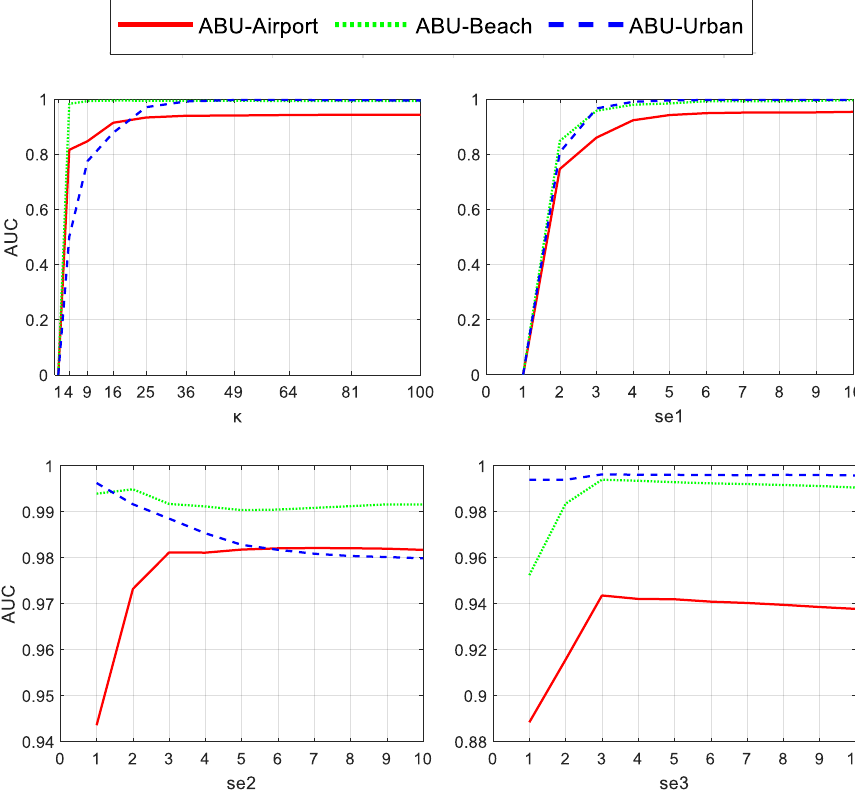
Figure 13. Influence of the parameters, 𝜅 , 𝑠𝑒1 , 𝑠𝑒2 , and 𝑠𝑒3 over the MPAF performance.